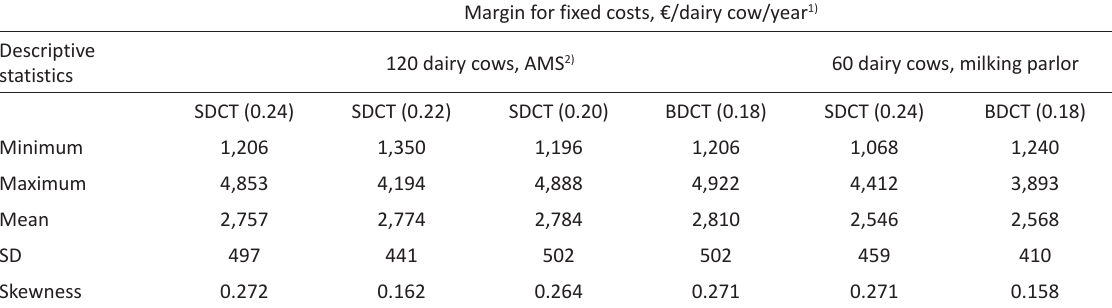
Table 3. Descriptive statistics of an annual margin for the fixed costs per dairy cow in herds implementing selective dry cow therapy (SDCT) and blanket dry cow therapy (BDCT) by herd size and milking system (probability of post-calving intramammary infection in